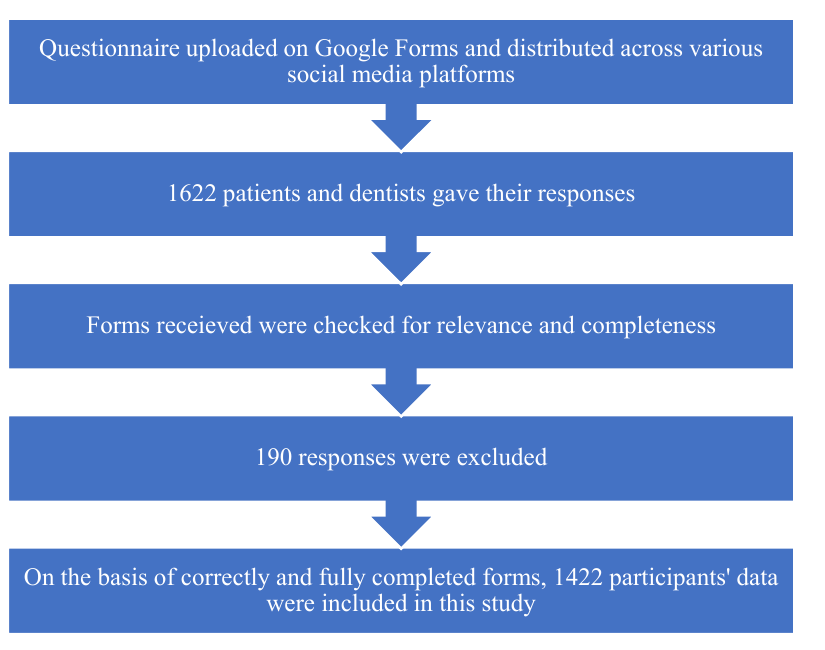
Figure 2. Flowchart of study participants’ recruitment. Table 1. Demographic characteristics of the patients (n =